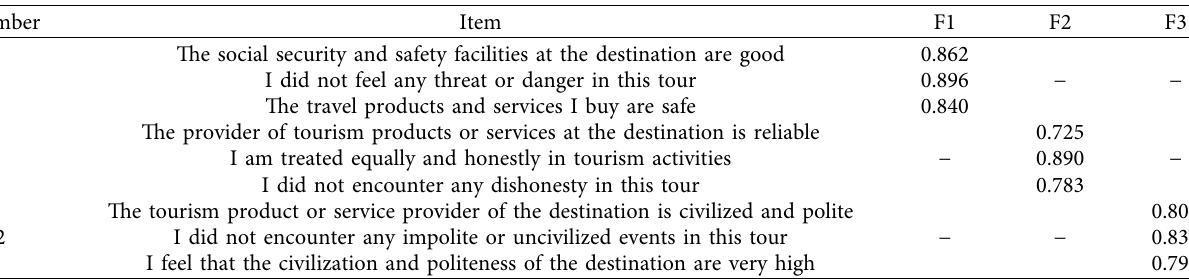
Table 4: Psychological effects of